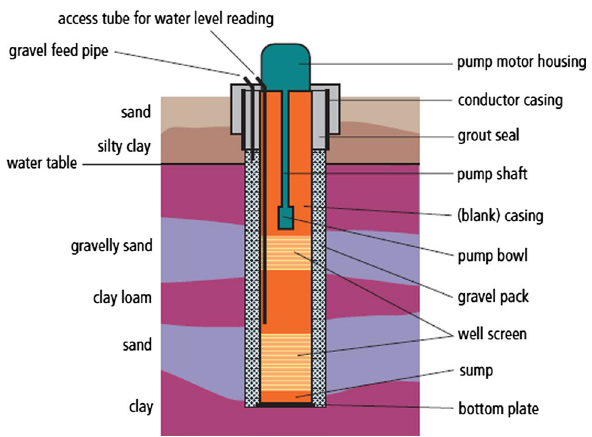
Fig. 7 Schematic diagram showing the essential components of a borehole. Adapted from Harter